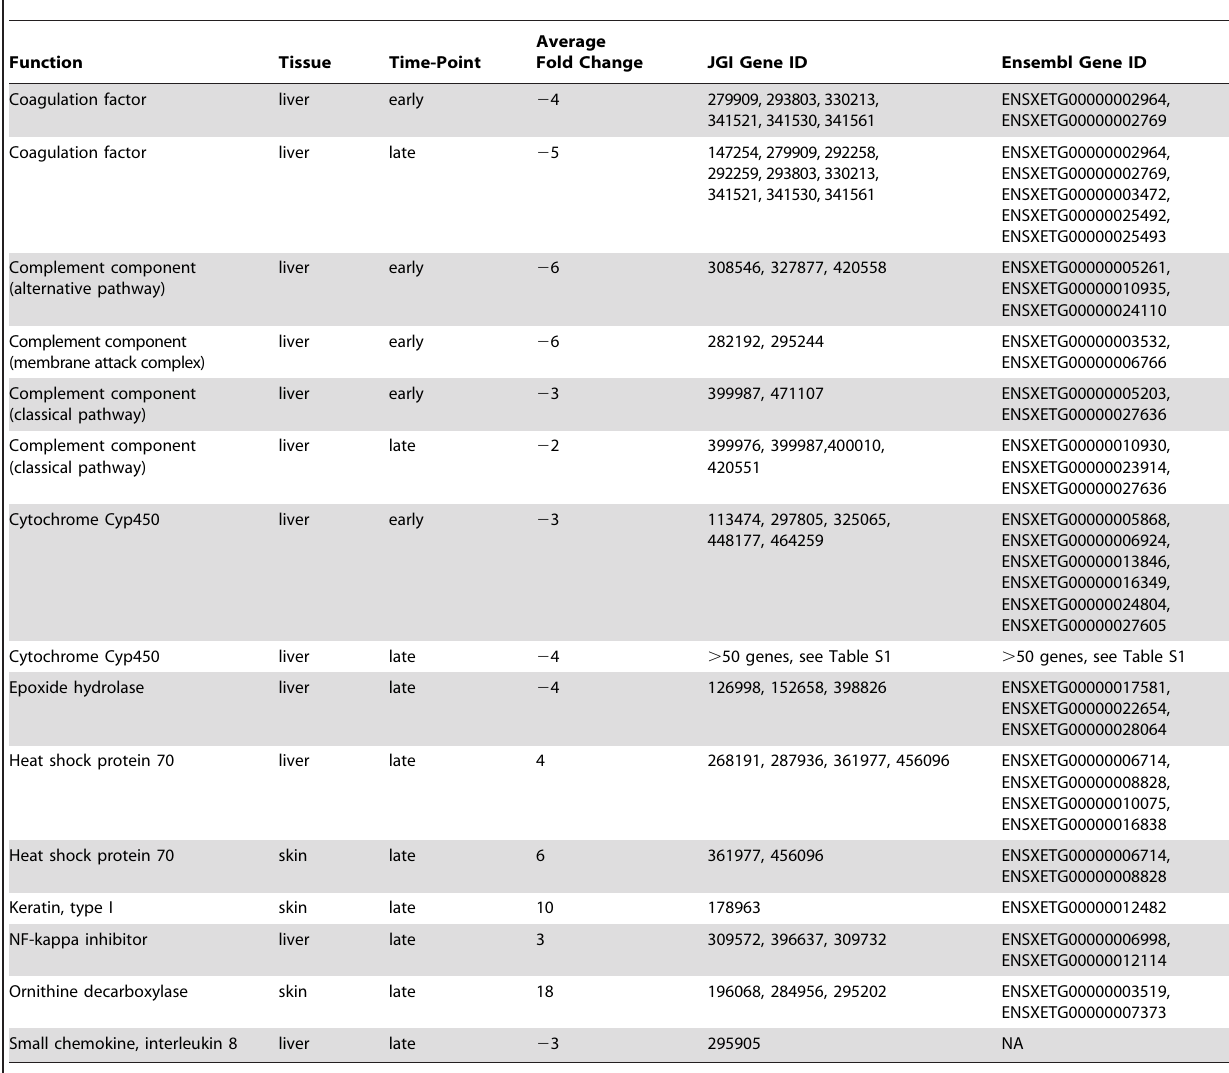
Table 1. Summary of immunological and physiological genes of interest with significant differences in expression between control and infected